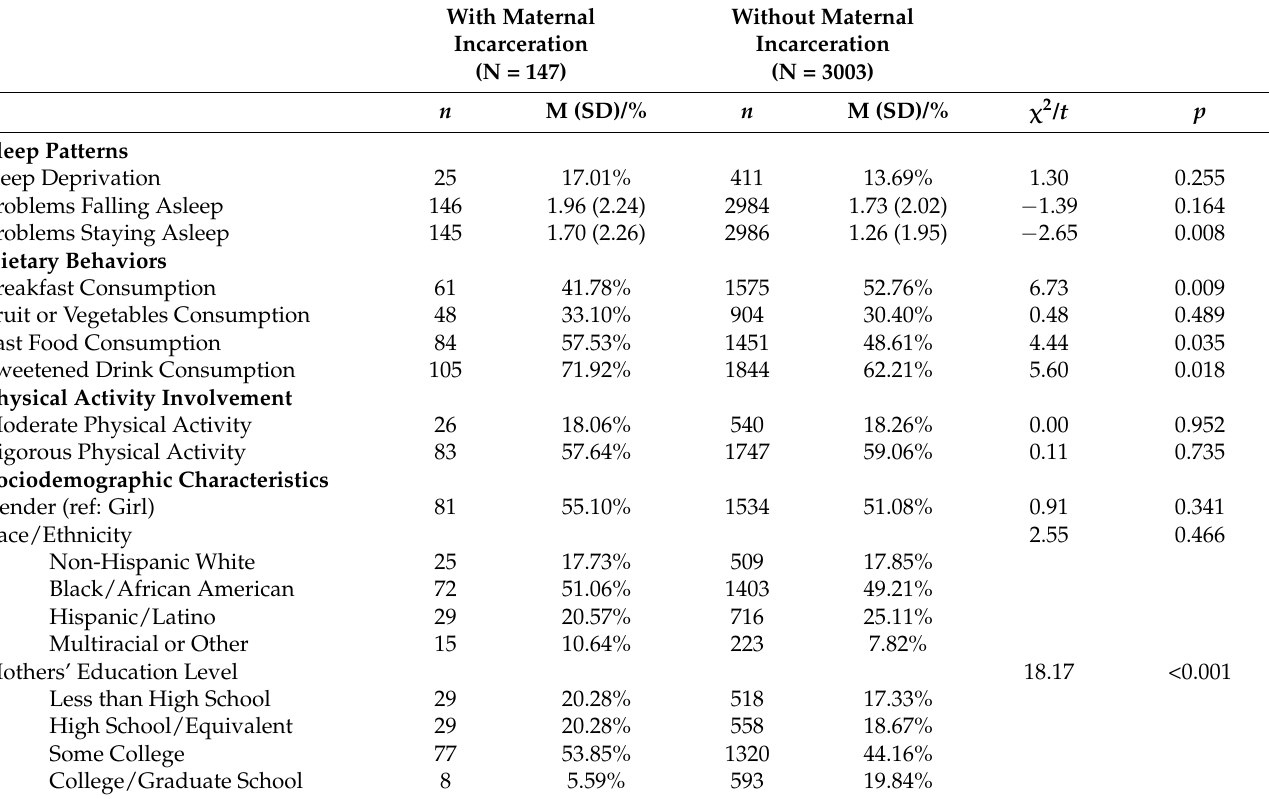
Table 2. Comparative analysis of adolescents with and without maternal incarceration histories in health risk behaviors and sociodemographic characteristics, FFCW (N =